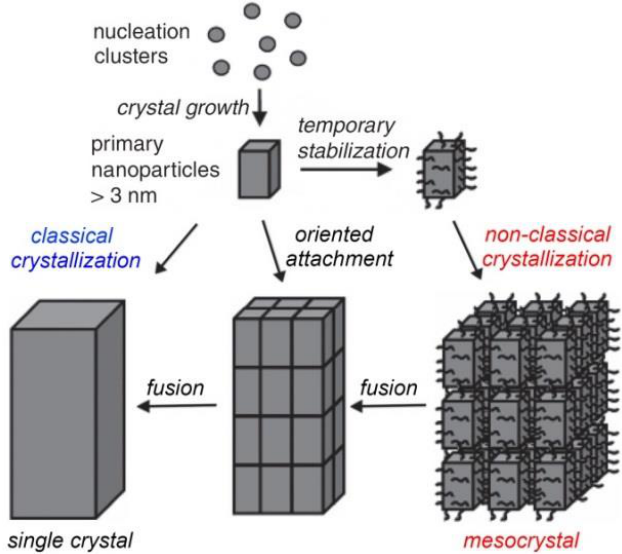
Figure 1. Schematic illustration of the single-crystal formation from classical crystallization, oriented attachment and non-classical crystallization. Reprinted with permission from [33]. Copyright John Wiley & Sons Inc., 2005.